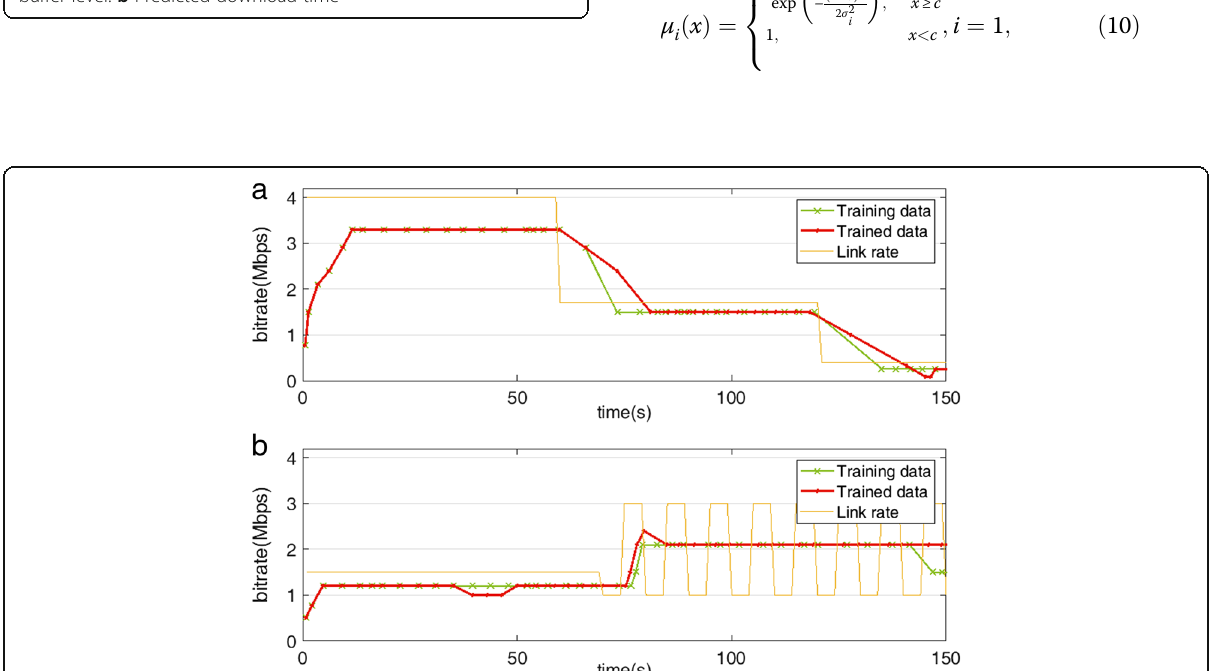
Fig. 4 The trained input fuzzy membership functions. a Current buffer level. b Predicted download time